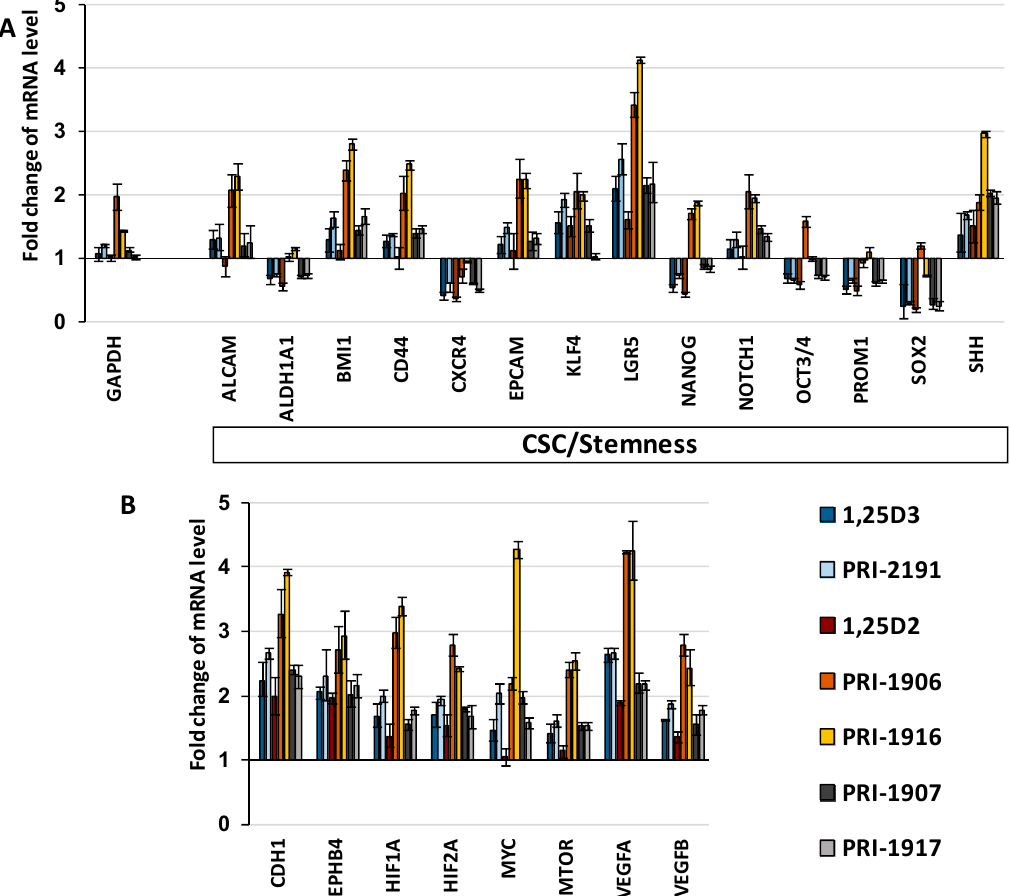
Figure 6. ( A ) gene expression analysis, performed with the use of 18S RNA as an endogenous control, revealed that both PRI-1906 and PRI-1916 differ from 1,25D2, PRI-1907, PRI-1917, 1,25D3 and PRI-2191 in the capability to regulate the expression level of CSC/stemness-associated genes in HT-29/5-FU cells undergoing renewal during four-day culture after cells passage and ( B ) more potently increased the relative expression level of several other genes. Fold differences were calculated using the ∆∆ C t method and are expressed as a range that is a result of incorporating the standard deviation of the ∆∆ C t value into the fold-difference calculation.